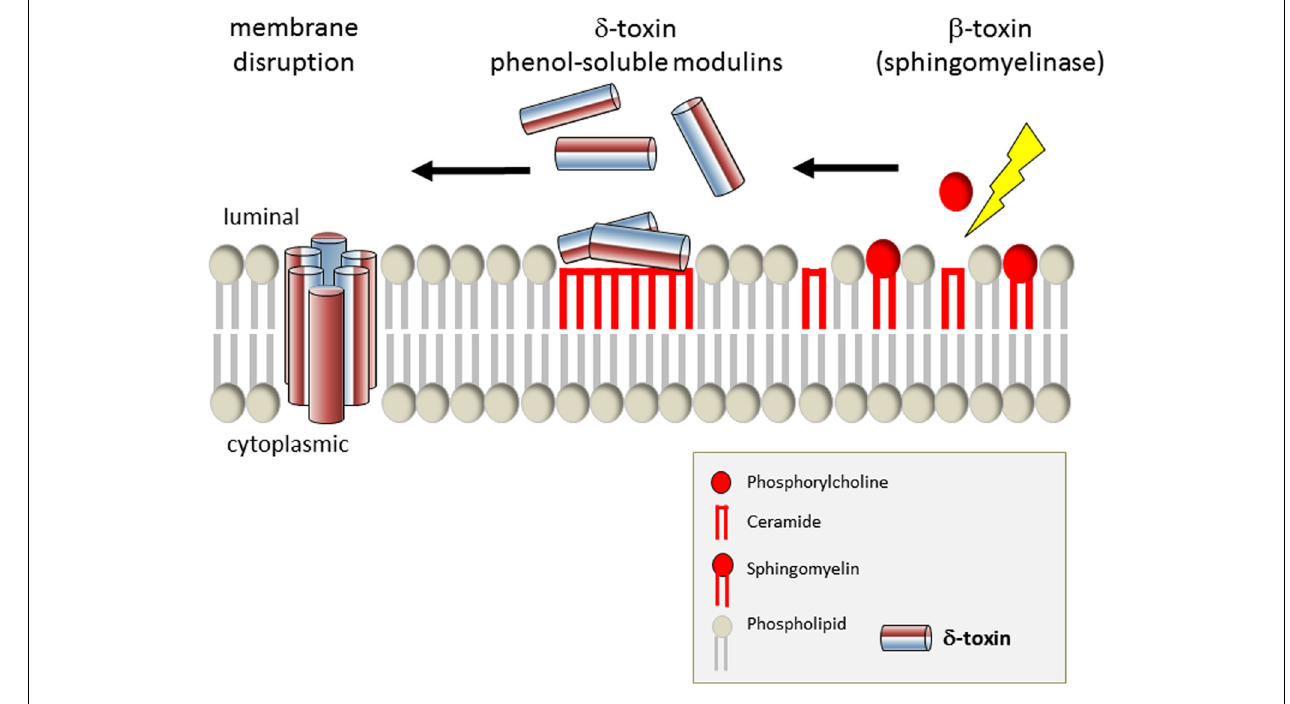
FIGURE 2 | Model of phagosomal escape by S. aureus by synergistic action of δ -toxin and β -toxin. After cleavage of sphingomyelin to ceramide and phosphocholine, δ -toxin is capable of interacting more efficiently with the